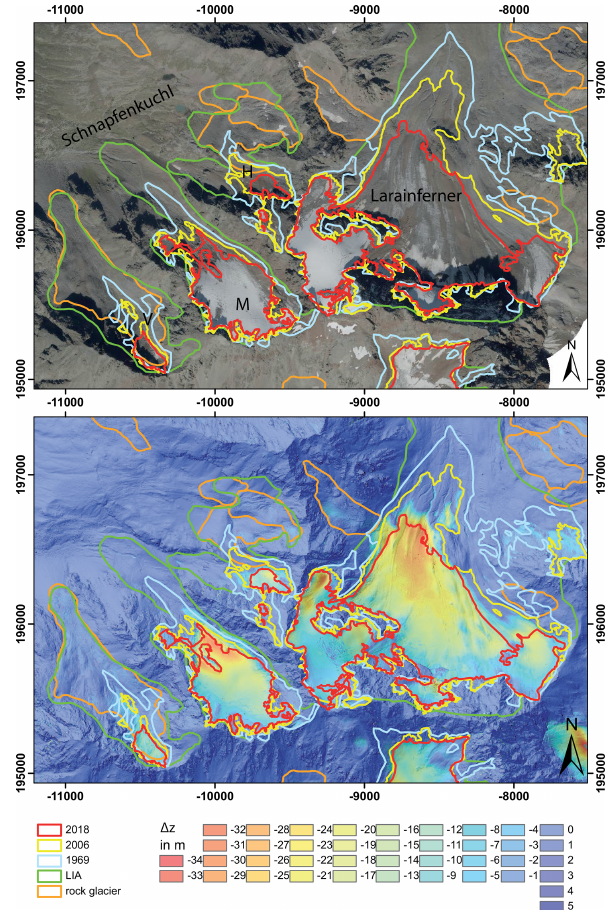
Figure 10. Final glacier outline 2018 and thickness changes 2006– 2018 for the Schnapfenkuchl glaciers V, M, and H and Larain- ferner displayed on (a) the orthophoto from 2020 and (b) the el- evation changes from 2006–2018 superimposed on the hillshade of 2018. Source orthophoto: CC 4.0 https://www.data.gv.at/katalog/